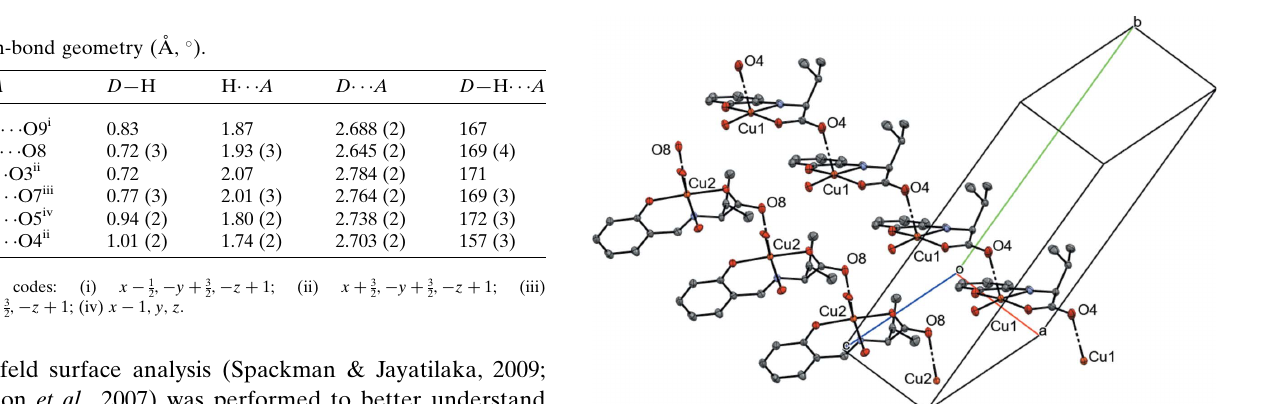
, (cid:5) y + 3 , (cid:5) z + 1; (iii) x + 1 , (cid:5) y + 3 , 2 2 2 2